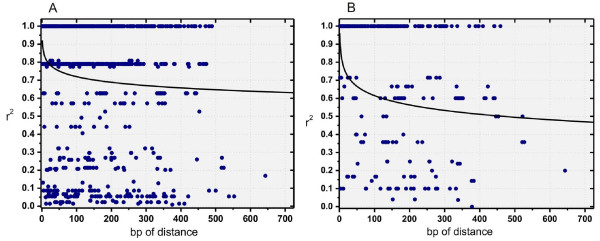
Linkage disequilibrium. A: LD plot from 24 genes pooled together for the 19 inbred lines. The logarithmic trend line reaches a value of 0.64 at 643 bp. B: LD plot from the whole gene data calculated for the G1 subset of individuals identified in the STRUCTURE analysis (HA52, HA61, HA89, HA370, HAR3, HAR5, KLM280, PAC2, RHA266, RHA274, RHA293 and RHA374).